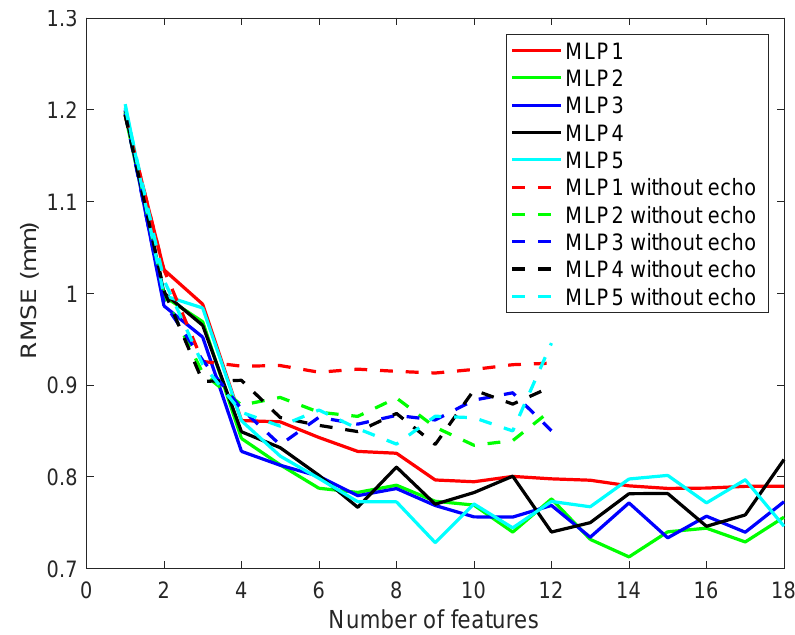
Figure 11. RMSE obtained depending on the number of selected features considering different number of neurons in the MLPs.